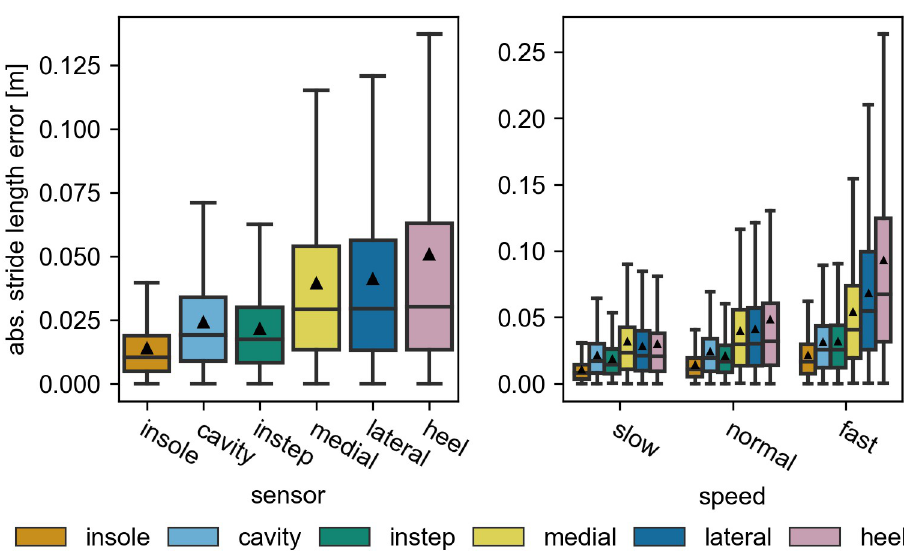
Fig 6. The absolute stride length error of each sensor position. On the left the error is calculated over all strides and right for the individual speed categories. All outliers ( > Q 3 + 1.5 IQR ) are removed from the visualization. The black triangles mark the means of the